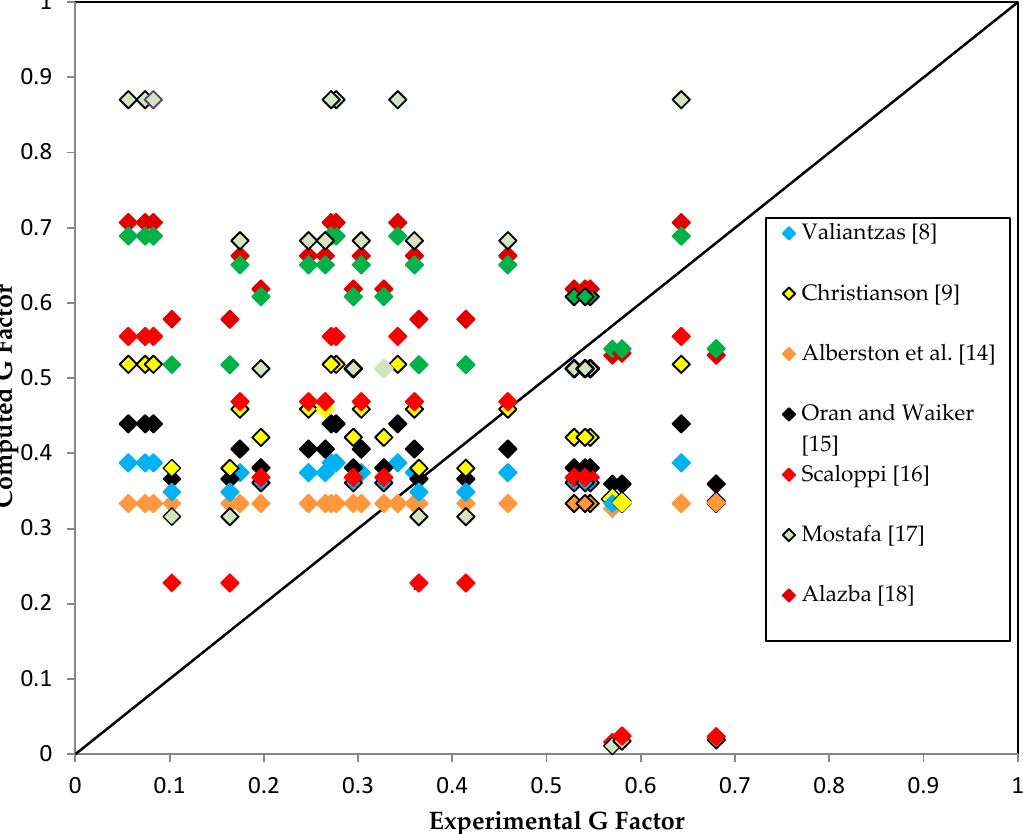
Figure 11. The Validation of the selected formulae for the G factor.